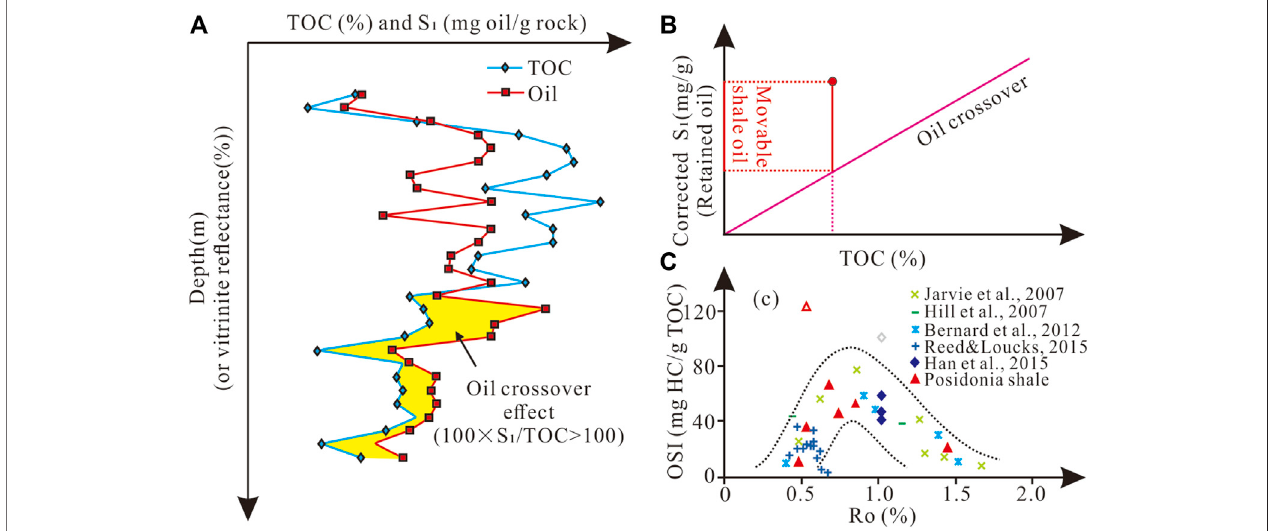
FIGURE7| Relationship between oil saturation index and TOC (A) (modi fi ed from Jarvie, 2012),movable oil content (B) (modi fi ed from Zhao X.Z. et al.,2020) and maturity (C) (from Han et al., 2017).